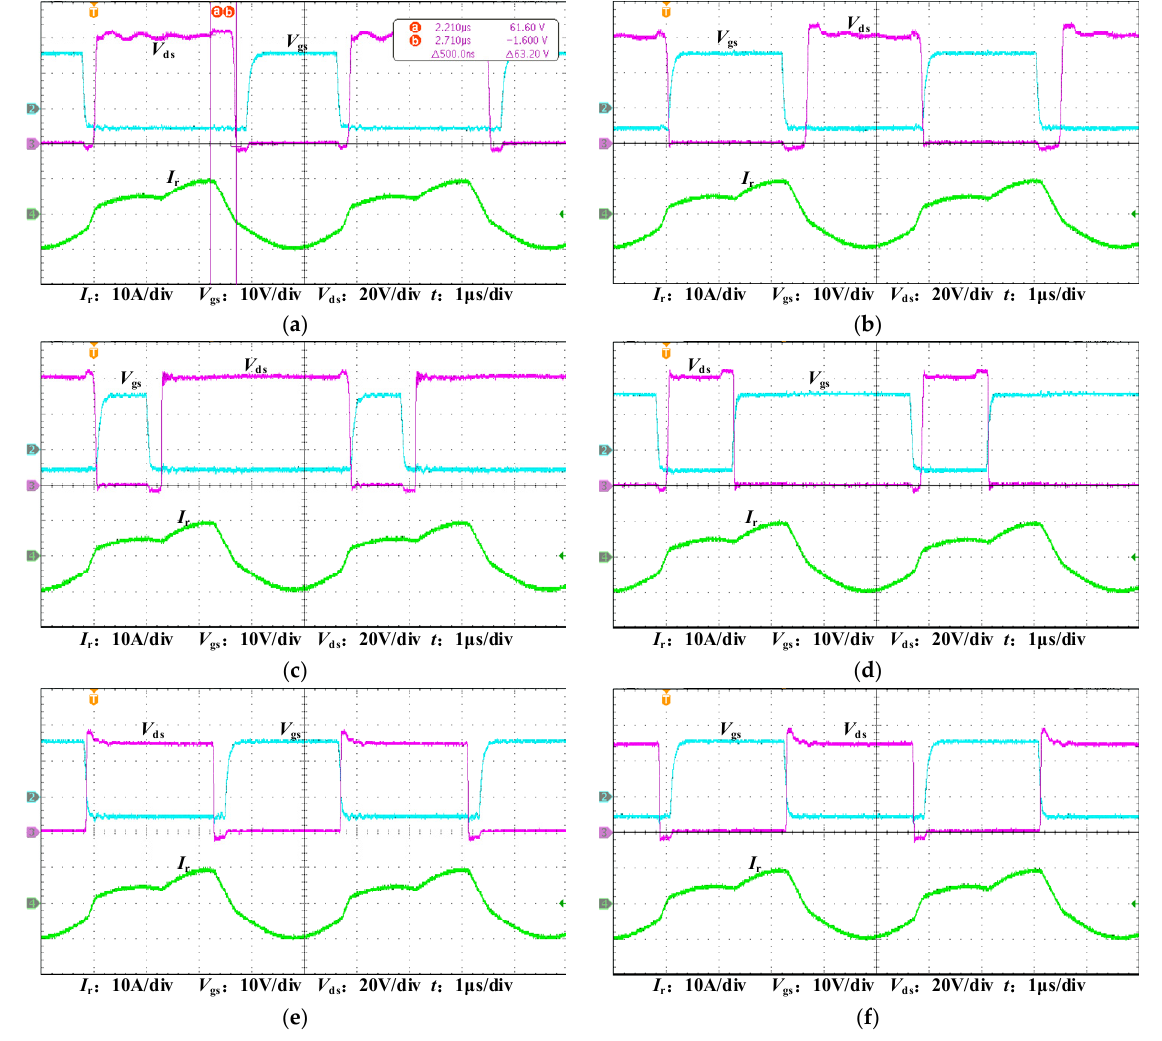
Figure 10. Soft switching waveforms of S 1 –S 6 . ( a ) S 1, ( b ) S 2 , ( c ) S 3 , ( d ) S 4 , ( e ) S 5 , ( f ) S 6 .